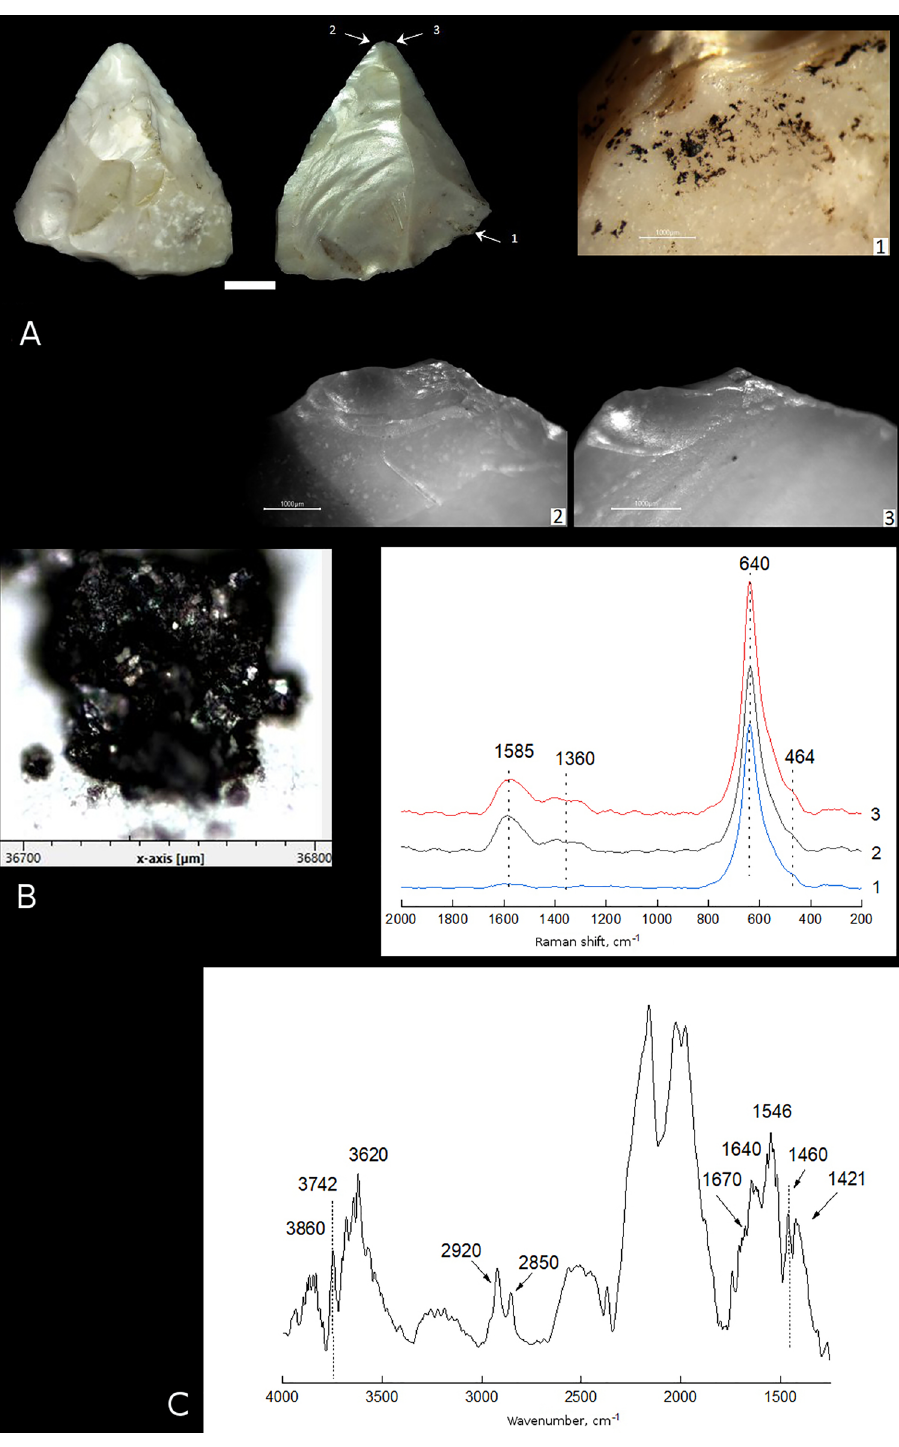
Figure 4. Use-wear and residue analyses of sample 3 found in Layer 6B at Saradj-Chuko grotto. ( A ) Photo of sample 3, scale bar = 1 cm. The arrows indicate position of close-ups of residues and use-wear traces shown on microscopic photos 1–3, scale bar = 1000 μm: (1) residues of black substance (bitumen) on the tool base, (2, 3) polishing and spin-off fractures on the tip. ( B ) SEM close-up on a sample of the black substance (bitumen residue) analyzed by FTIR and Raman spectroscopy, and Raman spectra of three residue samples. ( C ) FTIR spectrum of the same